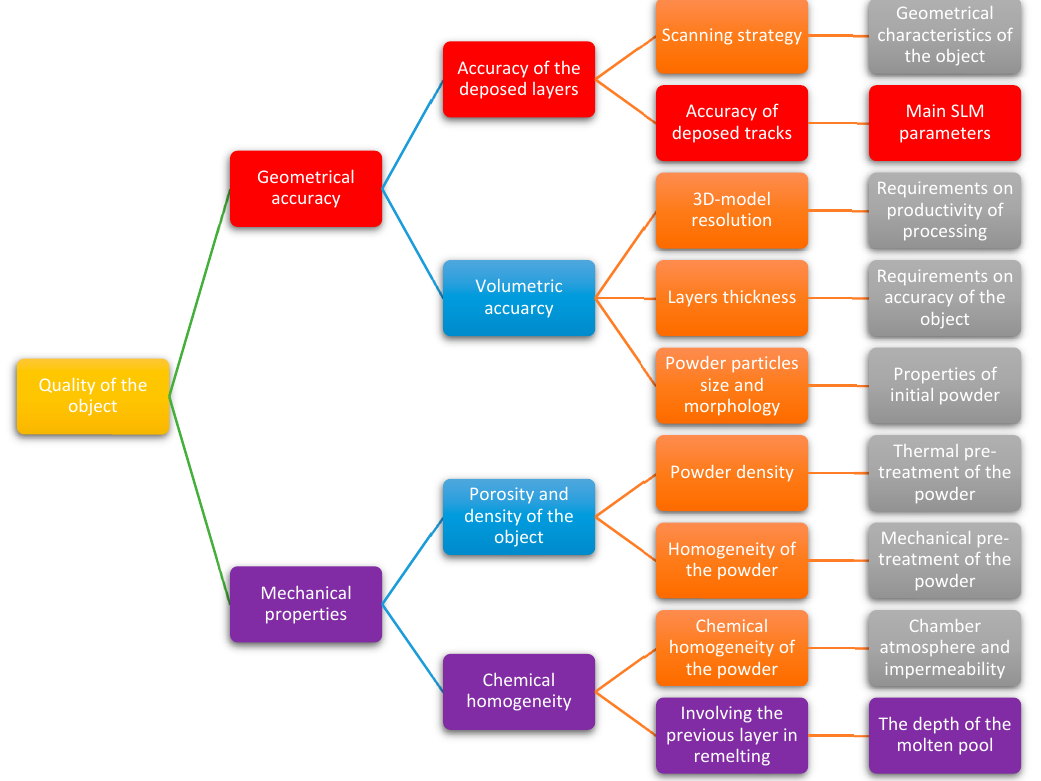
Figure 1. Graphical representation of the main technological aspects of selective laser melting/sintering, parameters and conditions and their influence on the quality of the object.